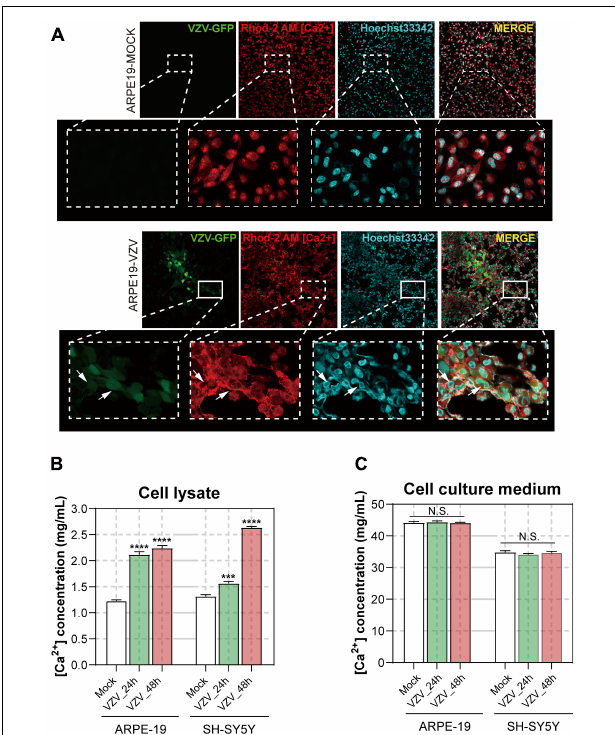
FIGURE 8 | Effect of VZV on Ca 2 + in ARPE-19 and SH-SY5Y cells. (A) The Rhod-2 AM calcium ion probe was used to assess the intracellular calcium ion distribution of ARPE-19 cells 72 h after VZV infection. The calcium colorimetric assay kit was used to evaluate the calcium ion content in the cell lysate (B) and cell culture supernatant (C) after VZV infection of ARPE-19 and SH-SY5Y cells at 24 h and 48 h, respectively. Data are expressed as the mean ± SD from at least three independent experiments (compared to the Mock group, *** P < 0.001, **** P < 0.0001, N.S.; not significant). The white arrows indicate the distribution of calcium ions on the cell membrane